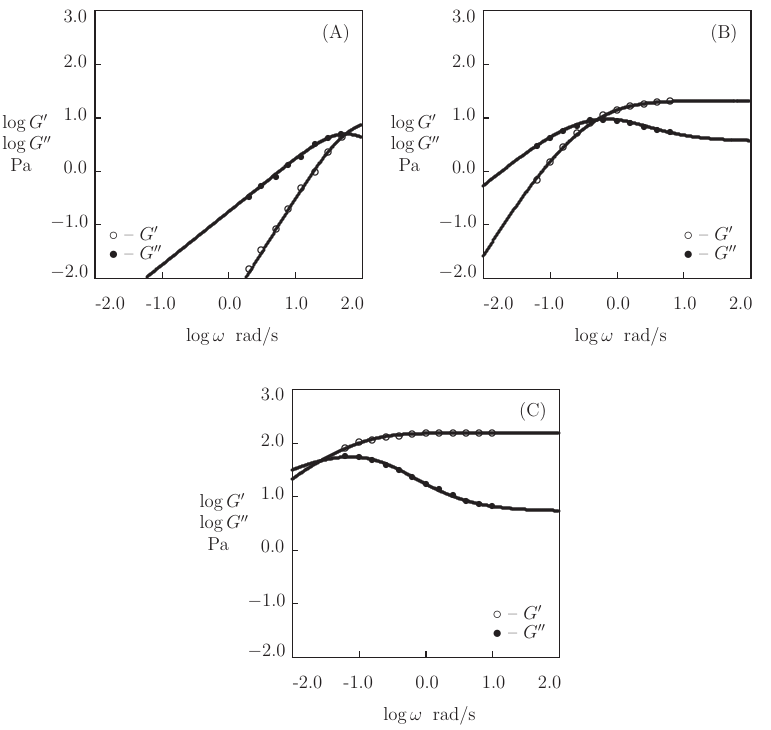
Figure 1. Storage modulus G (cid:48) and loss modulus G (cid:48)(cid:48) versus frequency ω . Symbols: experimental data [67] on hyaluronic acid gel cross-linked by benzoxaborin-saccharide complexation at various pH (( A )–pH = 6.0, ( B )–pH = 7.4, ( C )–pH = 9.0). Solid lines: the results of